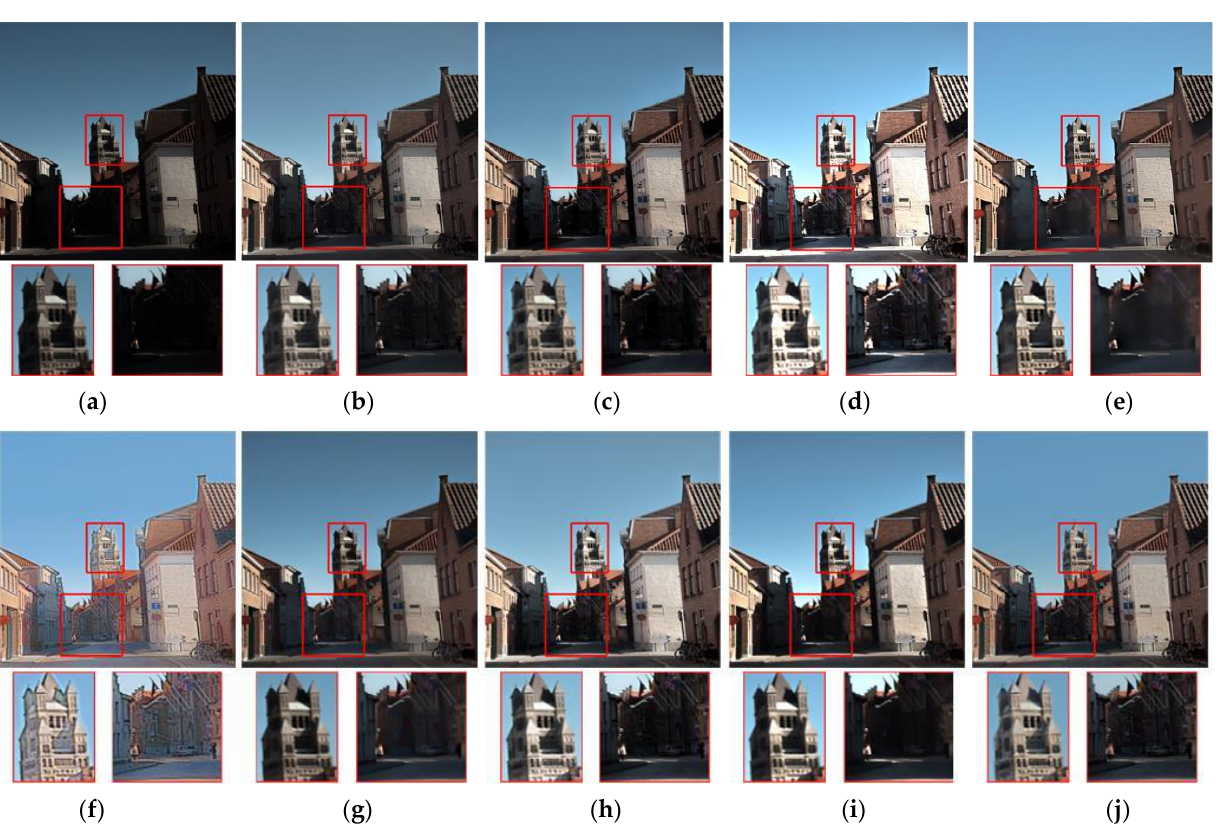
Figure 15. Enhanced results of “Town” image. ( a ) Original image; ( b ) BIMEF; ( c ) MEF; ( d ) LIME; ( e )